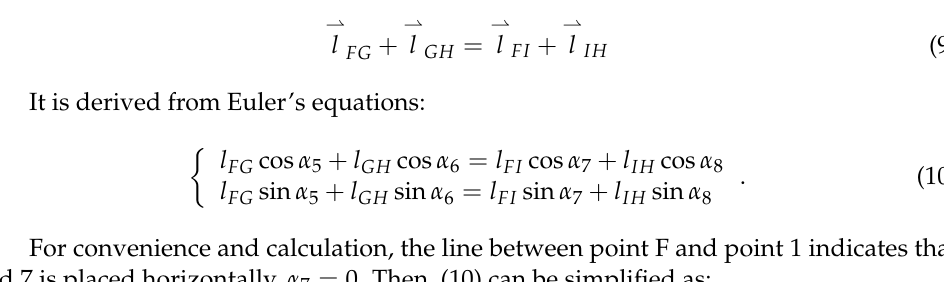
Figure 6. Schematic diagram of the equivalent mechanism of the third configuration. For the four-bar mechanism FGHI, the cartesian coordinate system is established with node F as the origin and rod l FI as the X-axis, and the vector equation can be